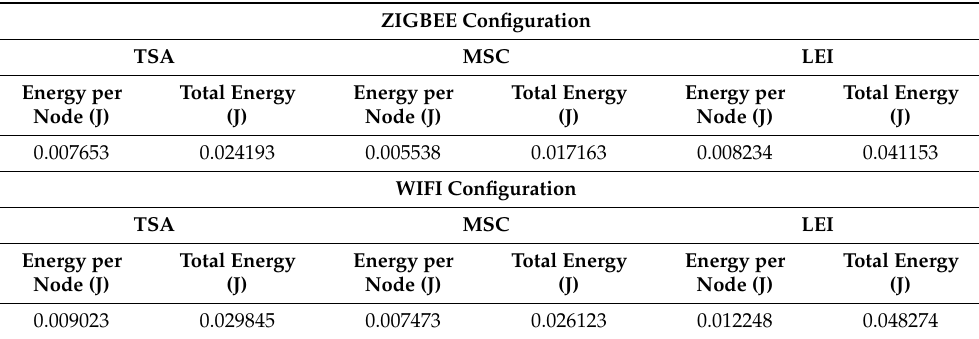
Table 10. Energy behavior per each studied algorithm under LEACH